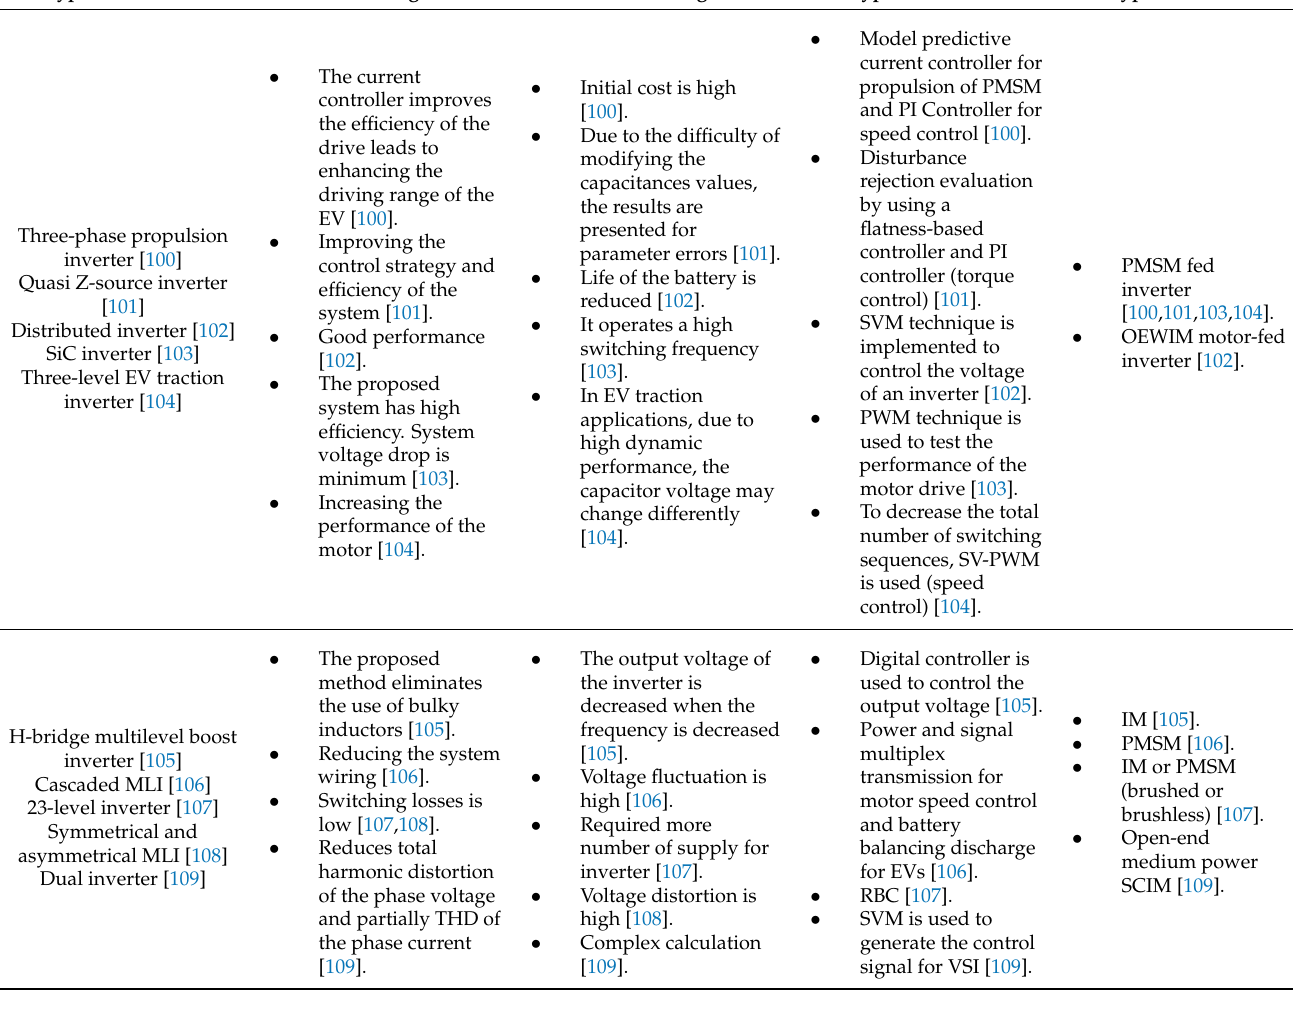
Table 11. Comparison of inverter and its motor control technique.